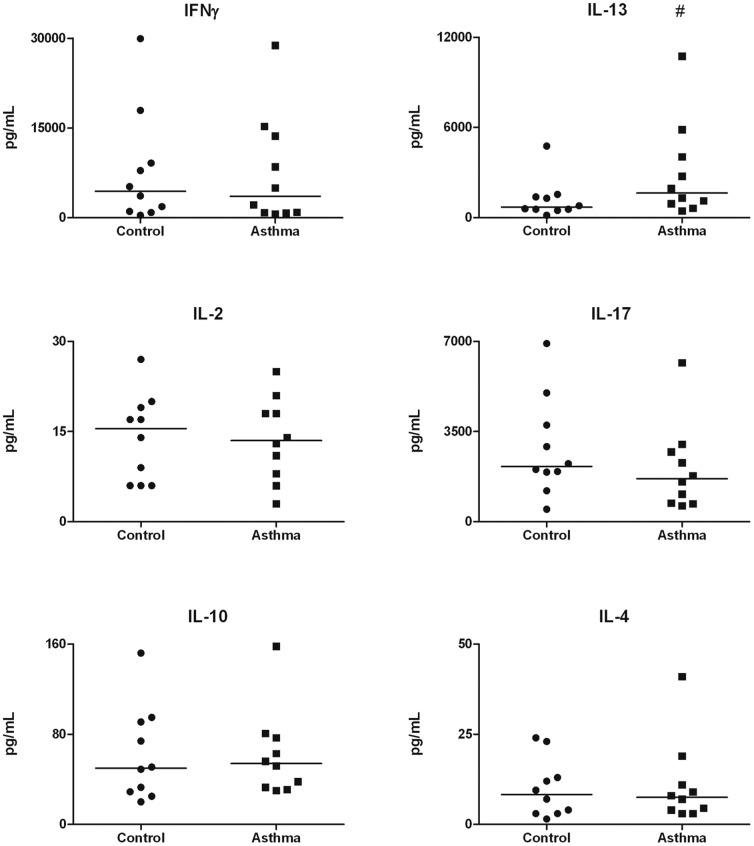
Cytokine responses upon stimulation with a purified House Dust Mite extract.PBMCs from asthma patients tended to produce more IL-13 than cells from healthy controls (1632 pg/mL v 695 pg/mL, p = 0.096). Other cytokines did not differ between asthma patients and healthy controls. Data are presented as single values and medians. # p<0.10.